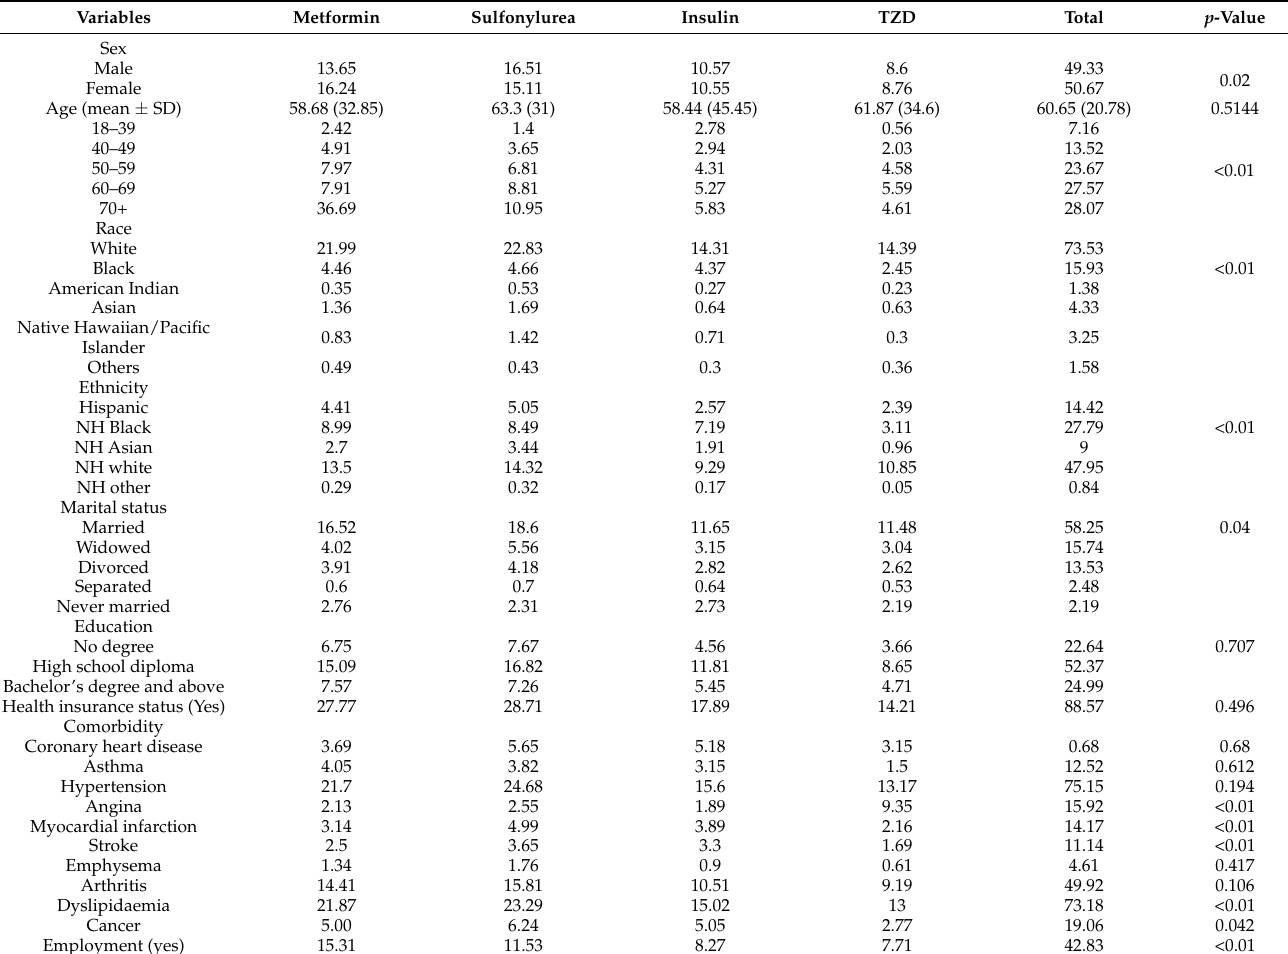
Table 1. Characteristics of the study participants, Wt